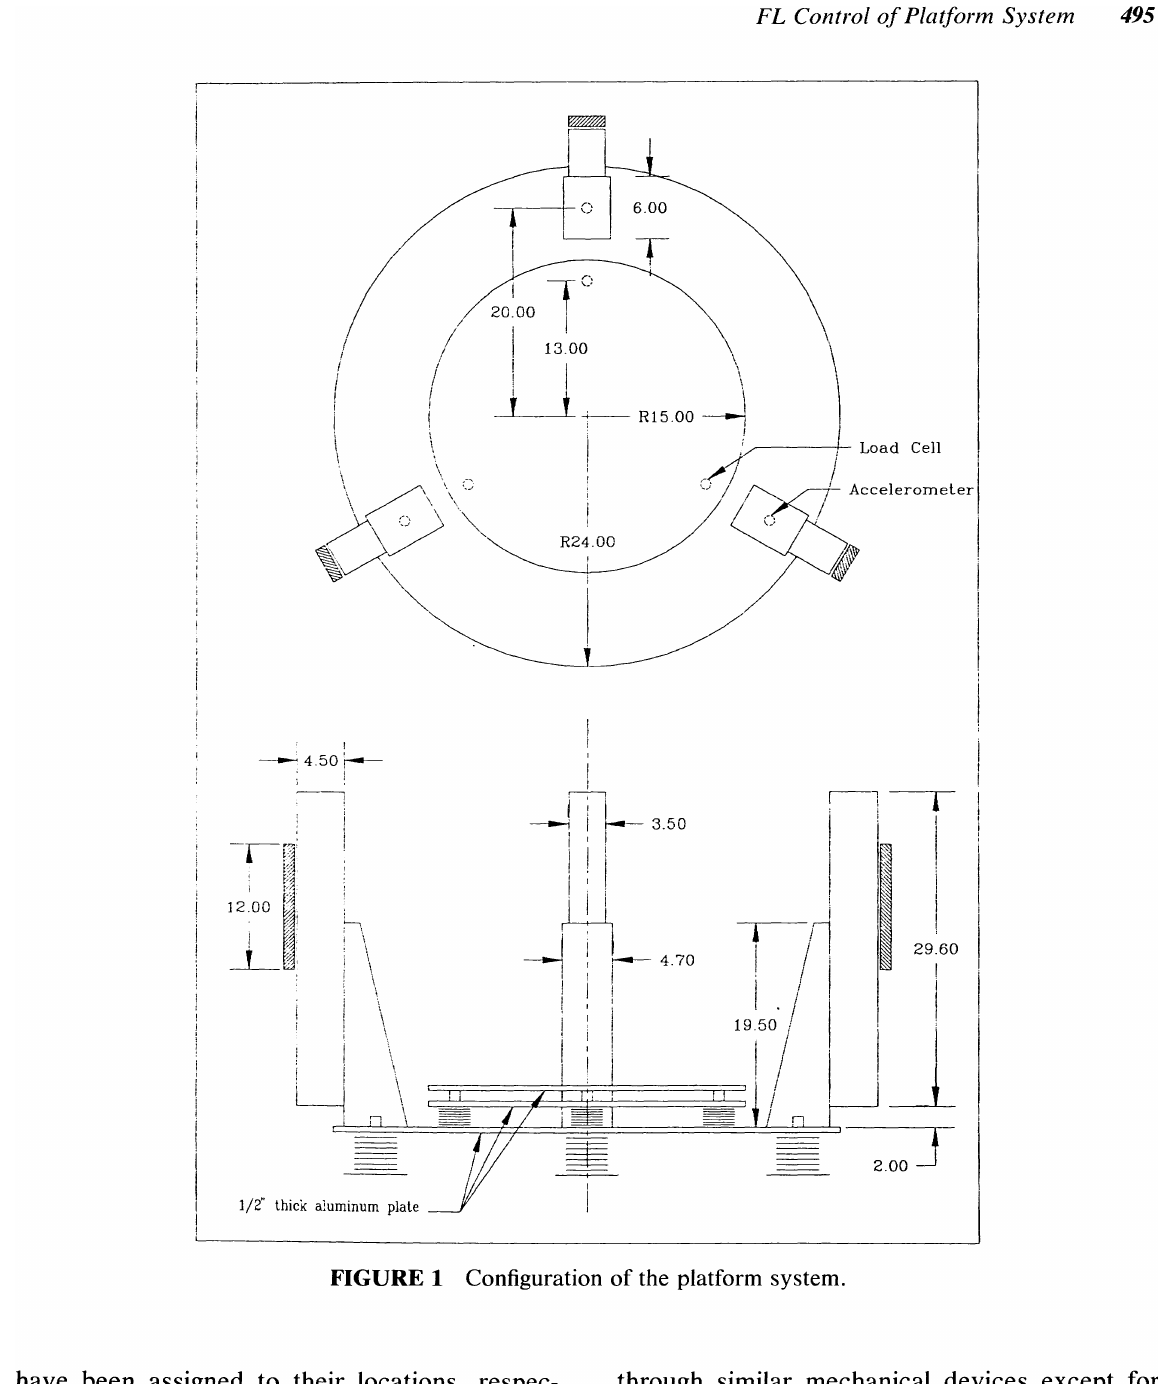
FIGURE 1 Configuration of the platform